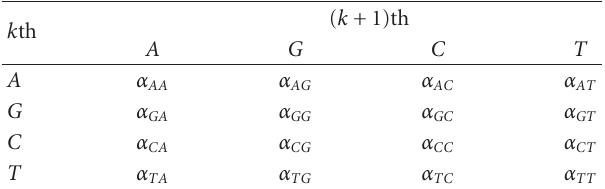
Table 8: Corresponding step cost of controls as shown in Table 7.